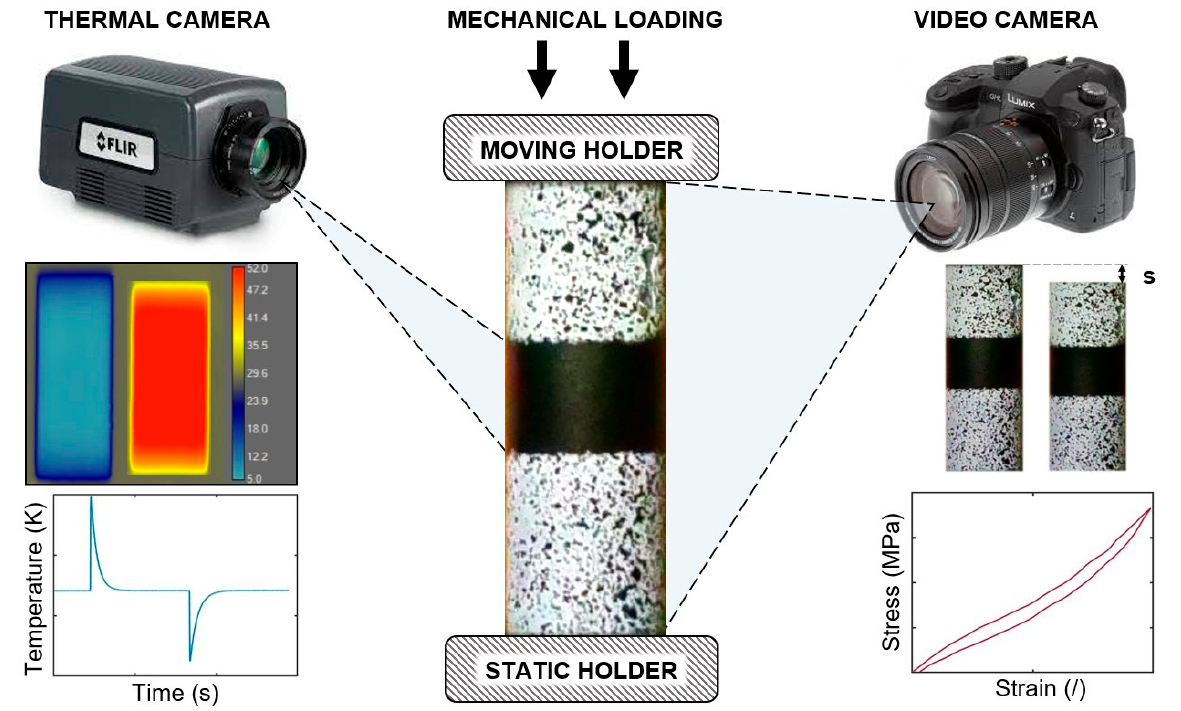
Figure 1. Schematic representation of the experimental setup for superelastic and elastocaloric characterization of the tube, showing the tube with the marked regions of interest for the thermal camera and video extensometer measurements.